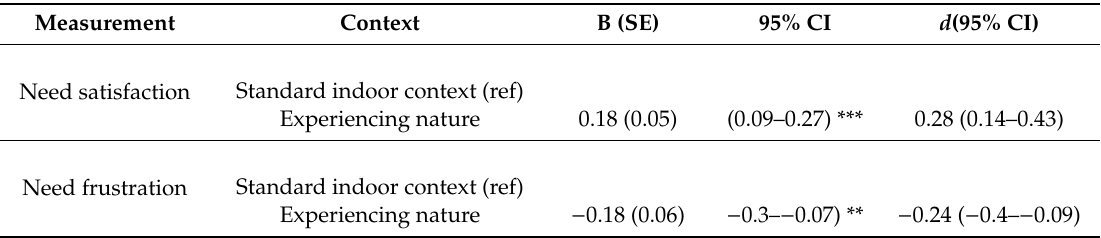
Table 2. Multilevel regression of the association between experiencing nature as opposed to being in the indoor context and parental need satisfaction and parental need frustration; regression coe ffi cient B with 95% confidence intervals, converted to Cohen’s d with 95%